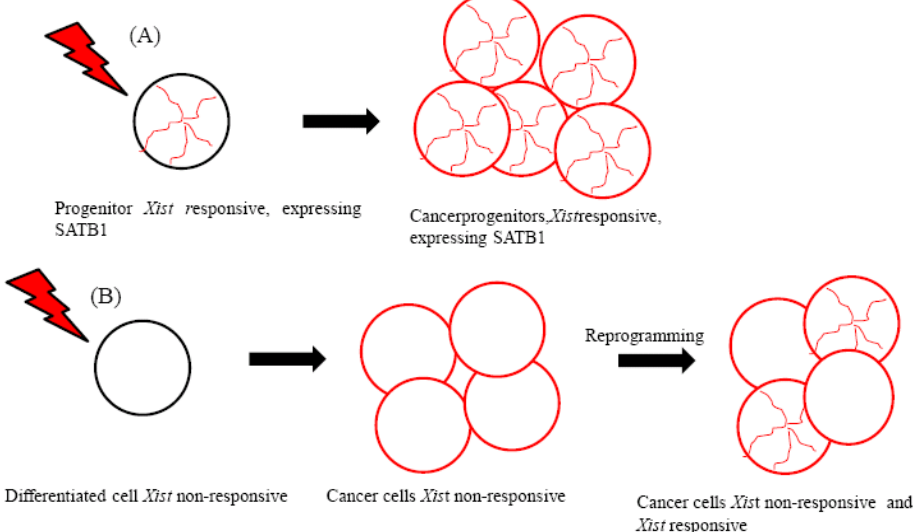
Figure 1. Epigenetic progenitor context A) Xist can silence the X chromosome in lymphoma cells arrested in a progenitor stage (e.g., double positive cells) and expressing SATB1 (in red). B) Other tumors such as breast cancer cells and cancer cells unresponsive to Xist may reprogram their genome, thus gaining metastatic potential. These malignant progenitors may express SATB1 and may be Xist